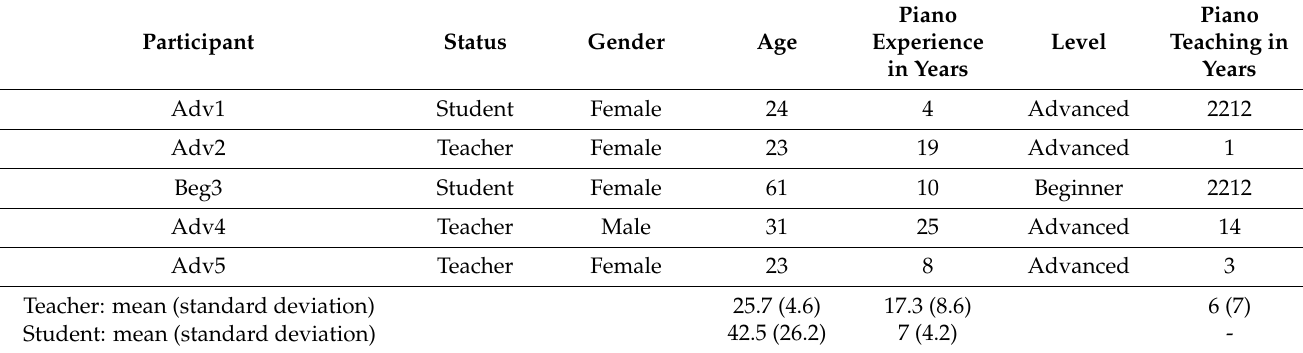
Table 1. Interview participants. Demographic information of interview participants and the respective